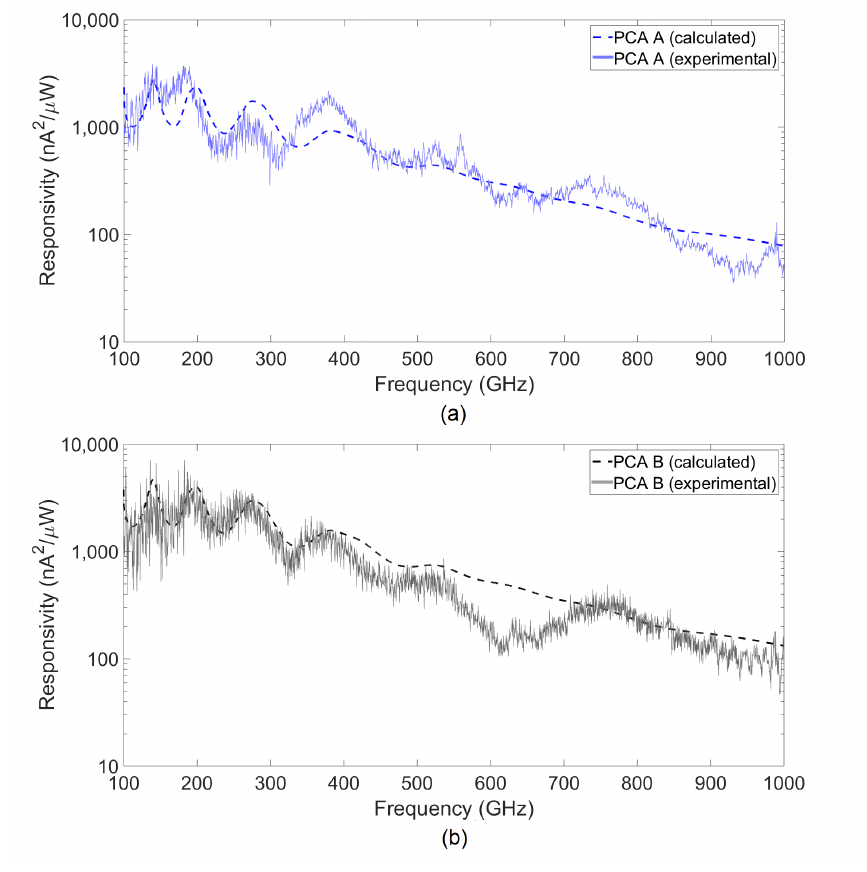
Figure 5. Comparison between the calculated and experimentally obtained responsivities of ( a ) PCA A ( b ) PCA B. η ef f is assumed THz